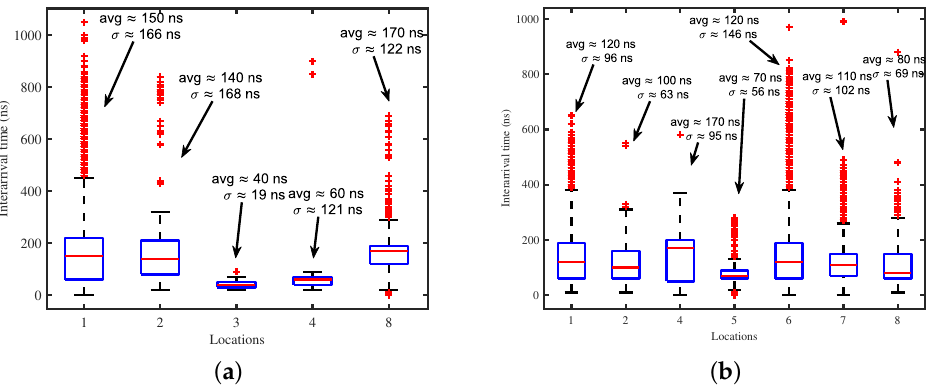
Figure 6. Box plot for the interarrival times of multipath components for Op1 and Op2 at all measurement locations, showing median value (red line), standard deviation (blue box), and outliers (red plus signs). ( a ) Op1 ( b ) Op2.